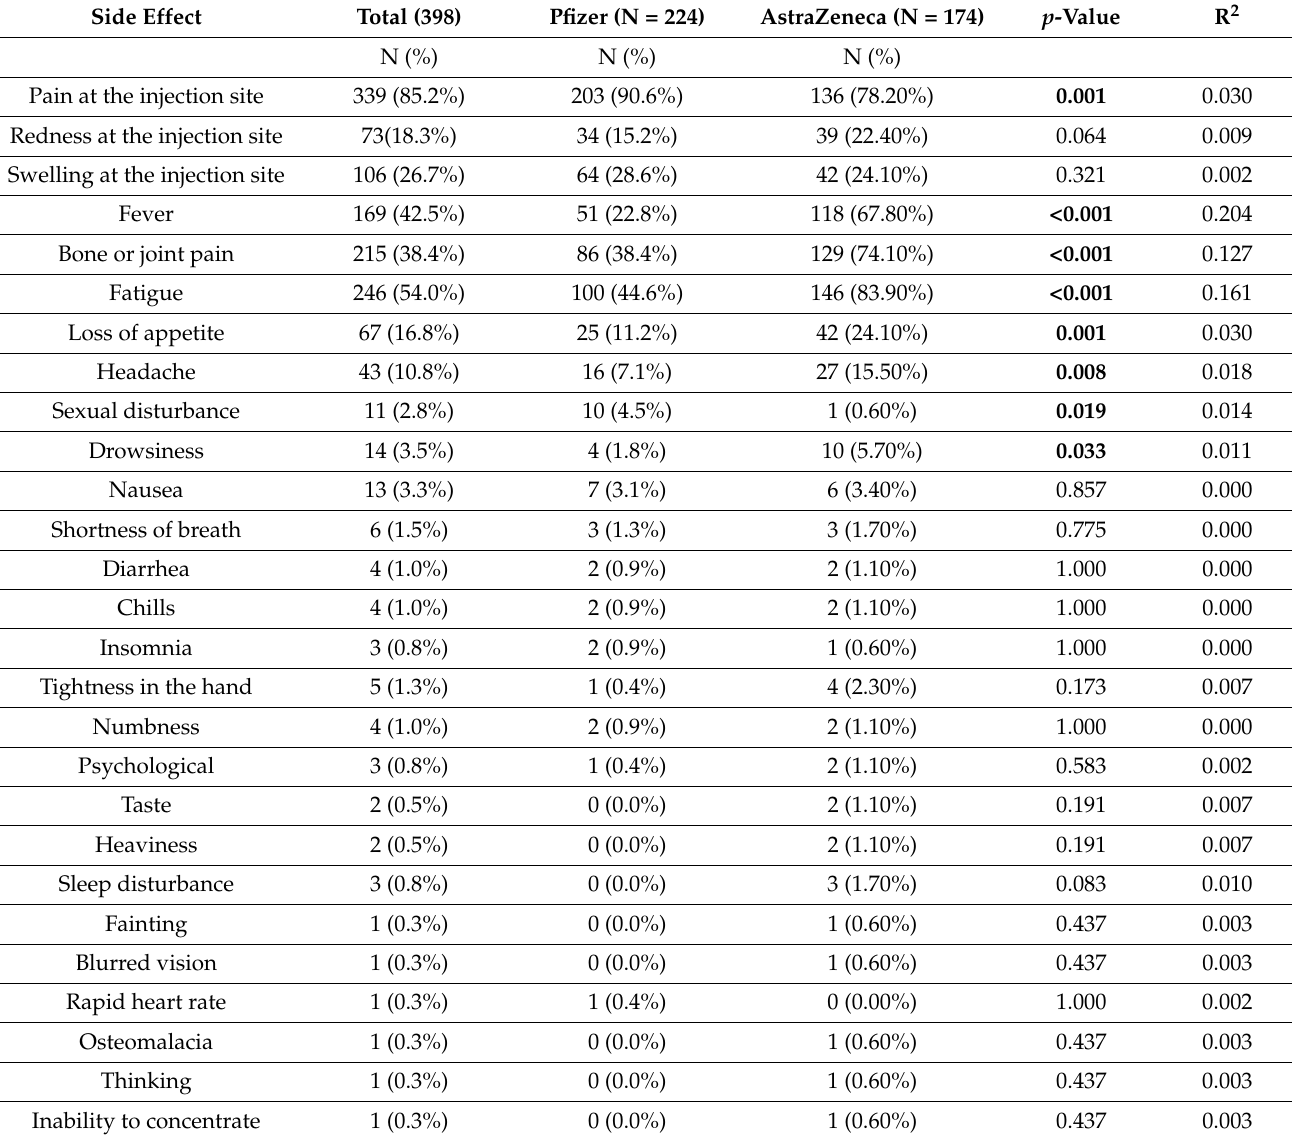
Table 3. Association of the side effects with the type of